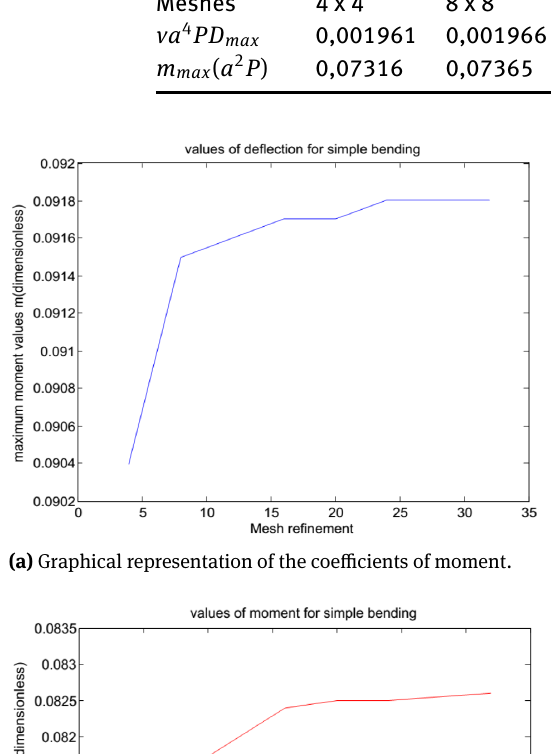
Table 3: Moment and deflection coeflcients for bending combined with compression for variable thickness (BCVT). Case2: BCVT